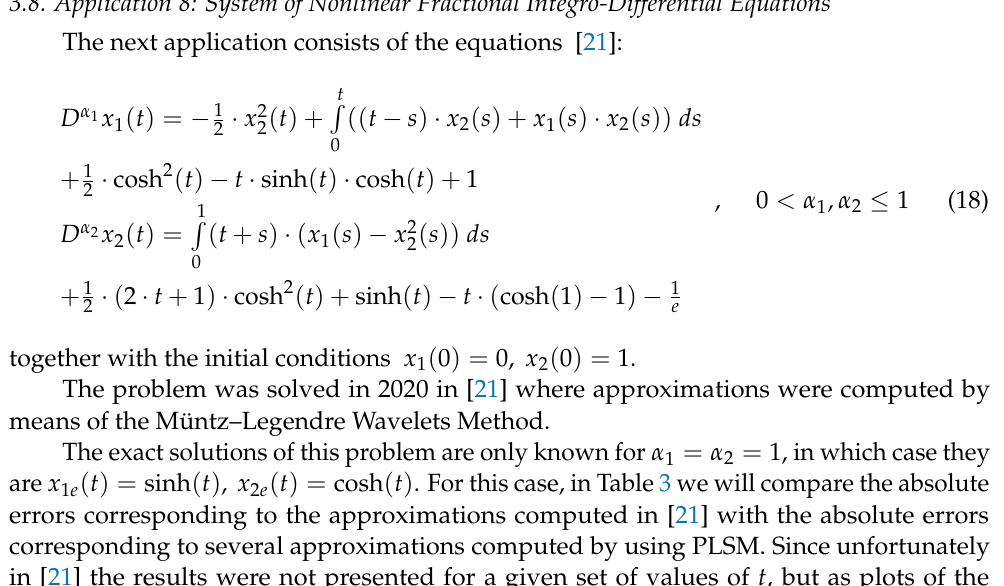
Table 5. Comparison of the maximal absolute errors of the approximate solutions x 1 (first row) and x 2 (second row) for problem (18) in the case α 1 = α 2 = 1. [21] PLSM 6-th deg. PLSM 7-th deg. PLSM 8-th deg. x 1 4 × 10 − 8 4 × 10 − 8 1 × 10 − 9 3 × 10 − 11 9 × 10 − 11